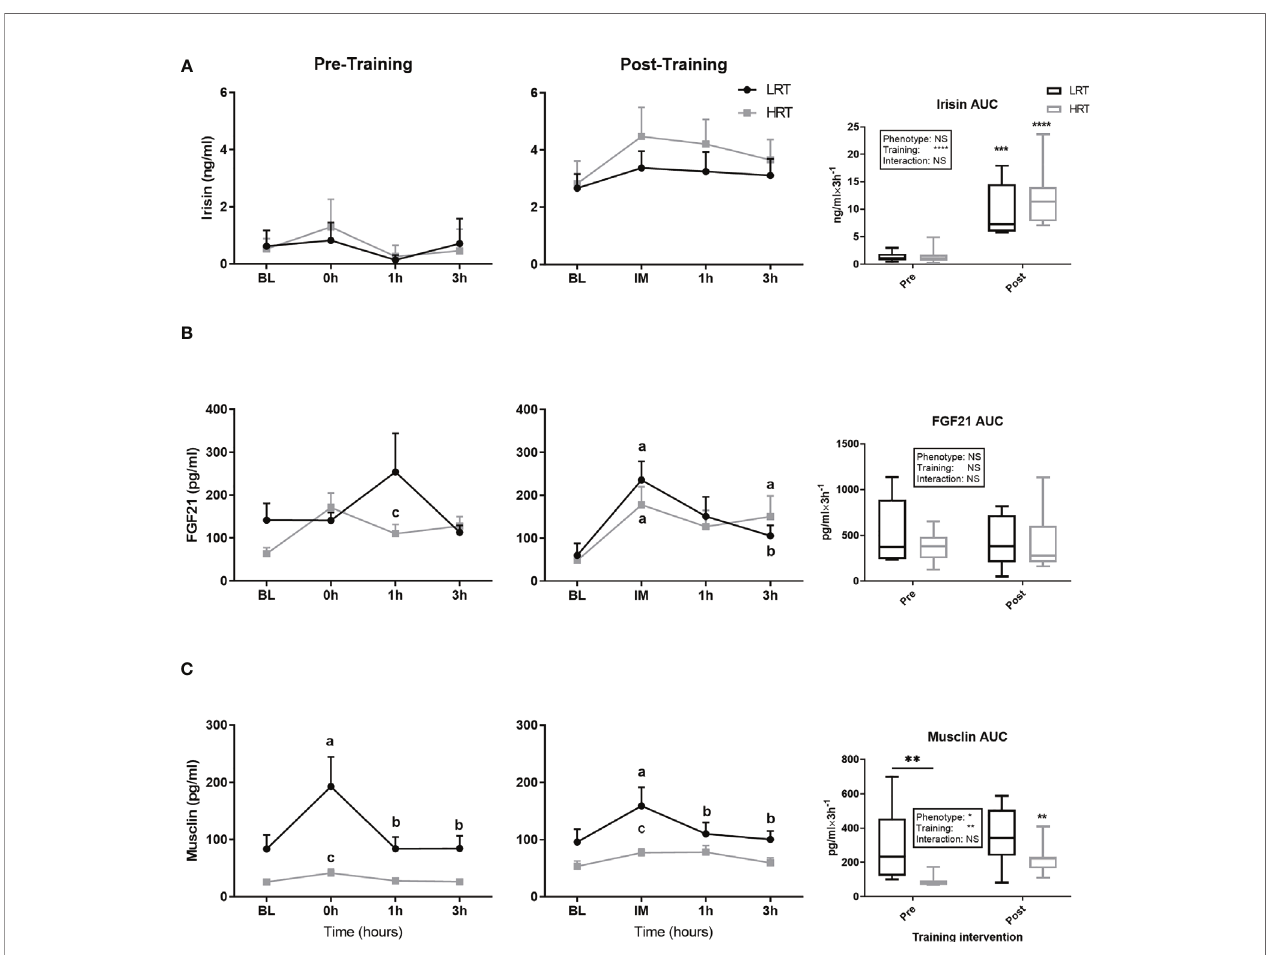
FIGURE 5 | Temporal change in concentration of plasma myokines and area under the curve (AUC) before and after exercise training. (A) Irisin (B) Fibroblast growth factors 21 (FGF21). (C) Musclin. Baseline (BL). Values are means±SD. Analysis via two-way ANOVA with Sidak ’ s post hoc test. Main effects are shown in the text box. *P ≤ 0.05, **P<0.01, ***P<0.001, ****P<0.0001, NS, Not Signi fi cant. a= signi fi cant change from BL. b= signi fi cant change from 0h. c. signi fi cant change across groups. Non-underlined symbols represent within group differences. Underlined symbols represent between group